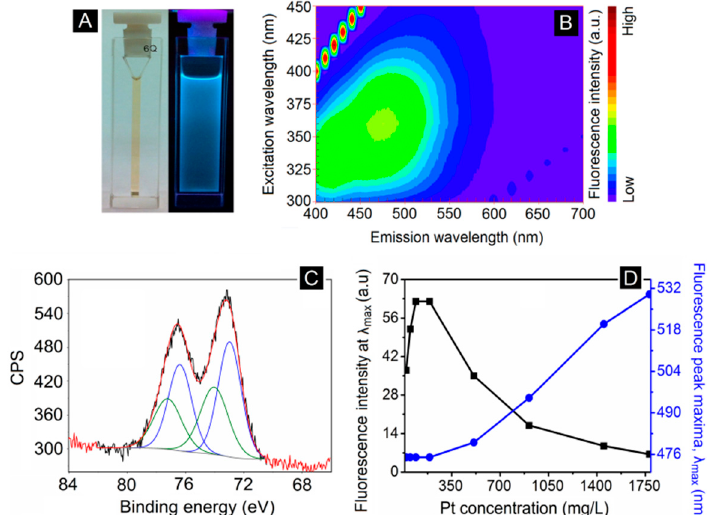
Figure 2. ( A ) Optical images under visible and 365 nm UV light, ( B ) 3D-fluorescence matrix contour plot, and ( C ) deconvoluted Pt 4f XPS spectrum (blue peaks for Pt 0 and green for Pt 2+ ) of the blue fluorescent Pt-NMQCs-Rec1-resilin nanobioconjugates. ( D ) Effect of Pt-NMQCs concentration on photoluminescence property of the blue fluorescent Pt-NMQCs-Rec1-resilin nanobioconjugates.